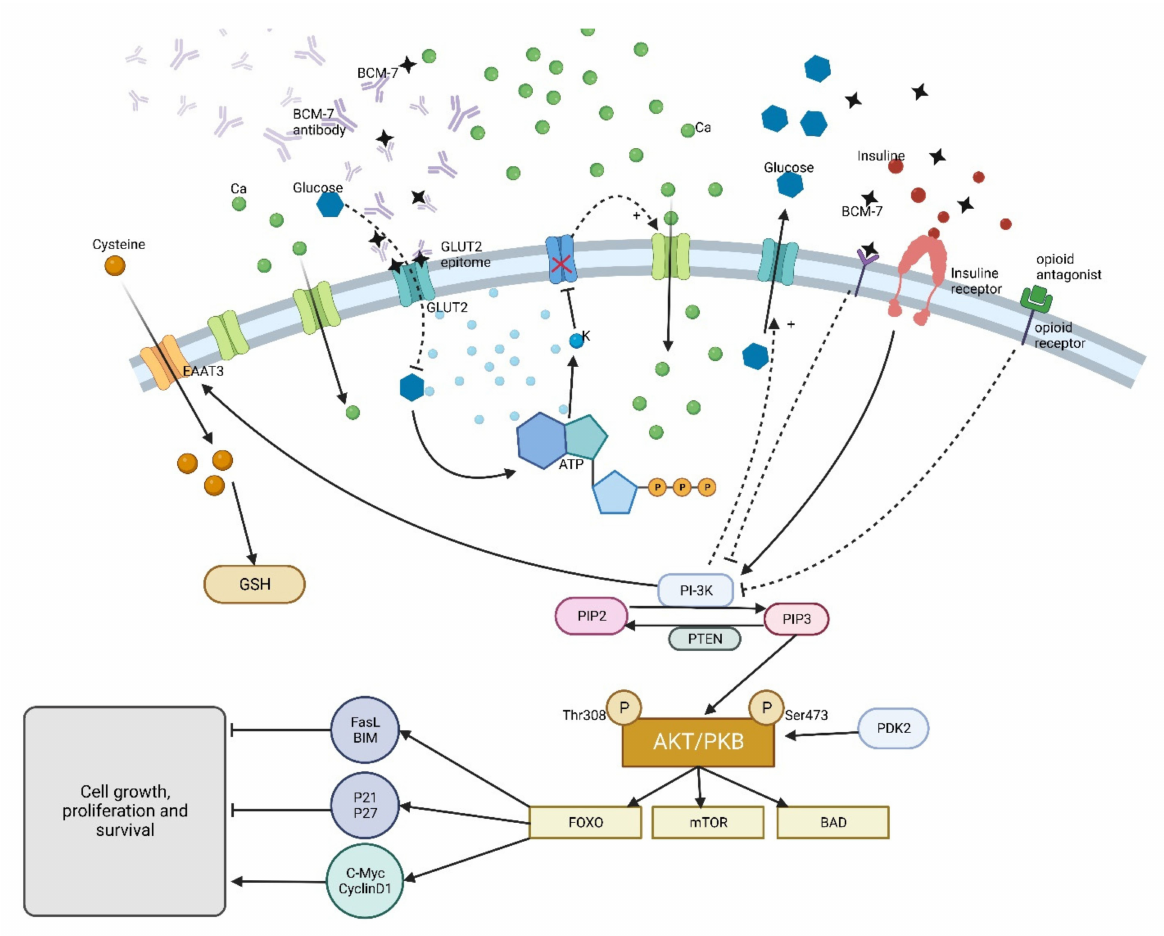
Figure 5. β -Casomorphin 7 pathway in the human